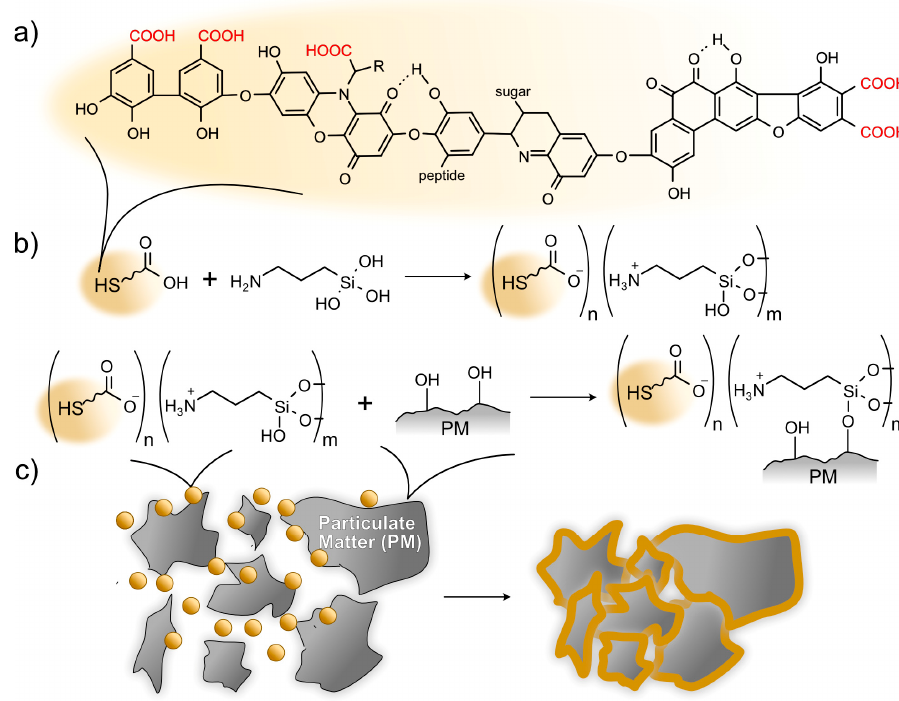
Figure 1. Model structure of humic acids [31]. ( a ) Scheme of the interaction of humic substances and 3-aminopropyltrihydroxysilane with the formation of humic substance–aminosilsesquioxane polyelectrolyte complexes (HS–ASQ) ( b ) and their binding to particulate matter ( c